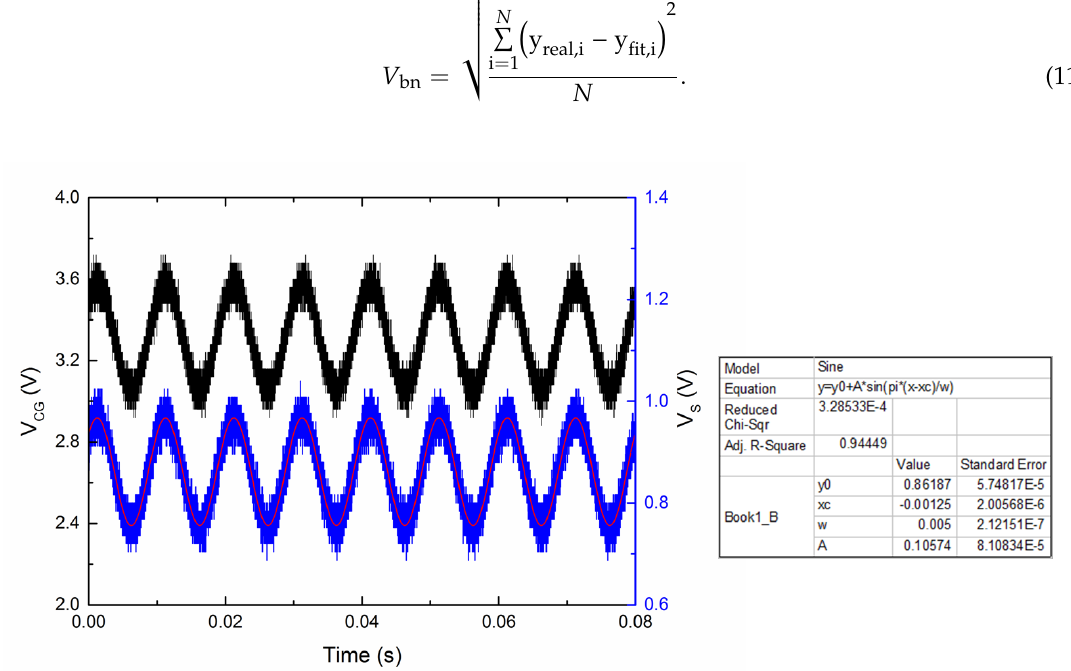
Figure 10. Characterization of device background noise in the circuit, where control gate CG 1 is applied with a standard sinusoidal signal (with a 3.3 V DC bias) as shown with the black line, and the output signal V S is shown with the blue line and fitted by a sinusoidal function as the red line with the fitting parameters given in the insets. The absolute value of the background noise is less than 0.33 mV.